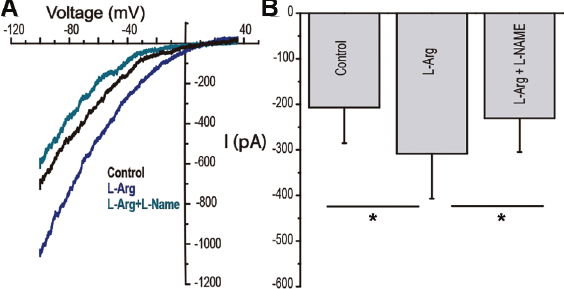
Figure 4. Three hundred m M L-arginine modulated purinergic currents. A , I (cid:2) V relationship of ATP-evoked currents in control (black), after 10 min L-arginine incubation (blue), and after 10 min treatment with 300 m M L-arginine + 1 mM L-NAME (light green). The bar graph in B shows the mean ± SE amplitude of the ATP current at – 70 mV. *P p 0.05, n=7 cells (ANOVA and Tukey post- test).